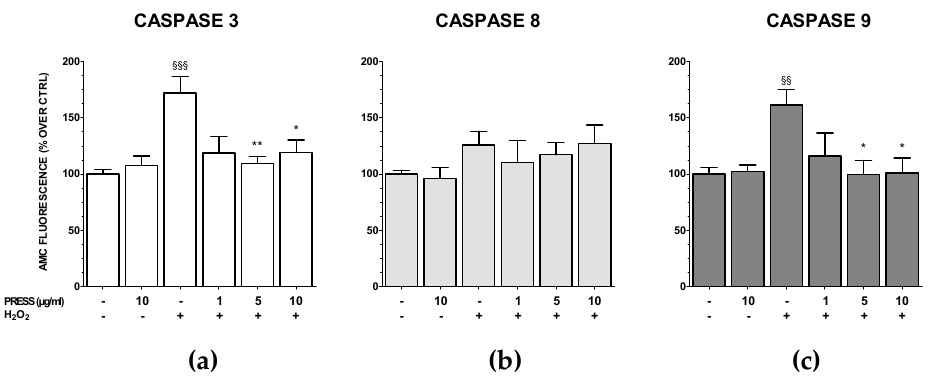
Figure 6. PRES-mediated effects on OS-induced changes in caspase-3, -8 and -9 activity in SH-SY5Y cells. Specific substrates for caspase-3 (a), caspase-8 (b) and caspase-9 (c), which release the fluorescence probe AMC (380 nm exc and 460 nm em) when activated, were used. Data are reported as mean ± SEMs. §§ p < 0.01, §§§ p < 0.001 vs. untreated cells; * p < 0.05, ** p < 0.01 vs. H 2 O 2 (ANOVA followed by Bonferroni